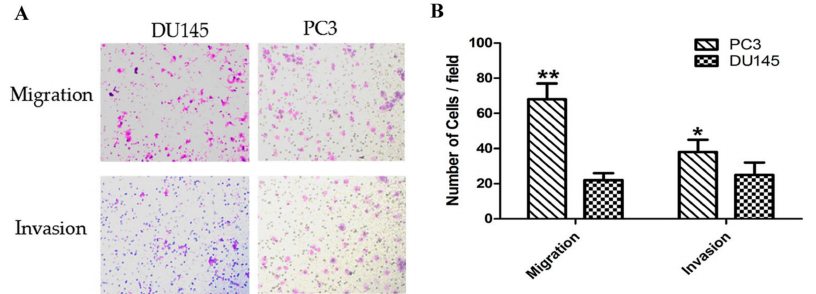
Figure 1. Comparison of migration and invasion capacity of prostate cancer cells. ( A ) Representative images of the invasion and migration of DU145 and PC3 cells taken by an inverted microscope (20 × objective); ( B ) Quantitative analysis of cell migration (2 h) and invasion (4 h) in DU145 and PC3 cells. * p < 0.05 ** p < 0.01. Per condition, three independent experiments were